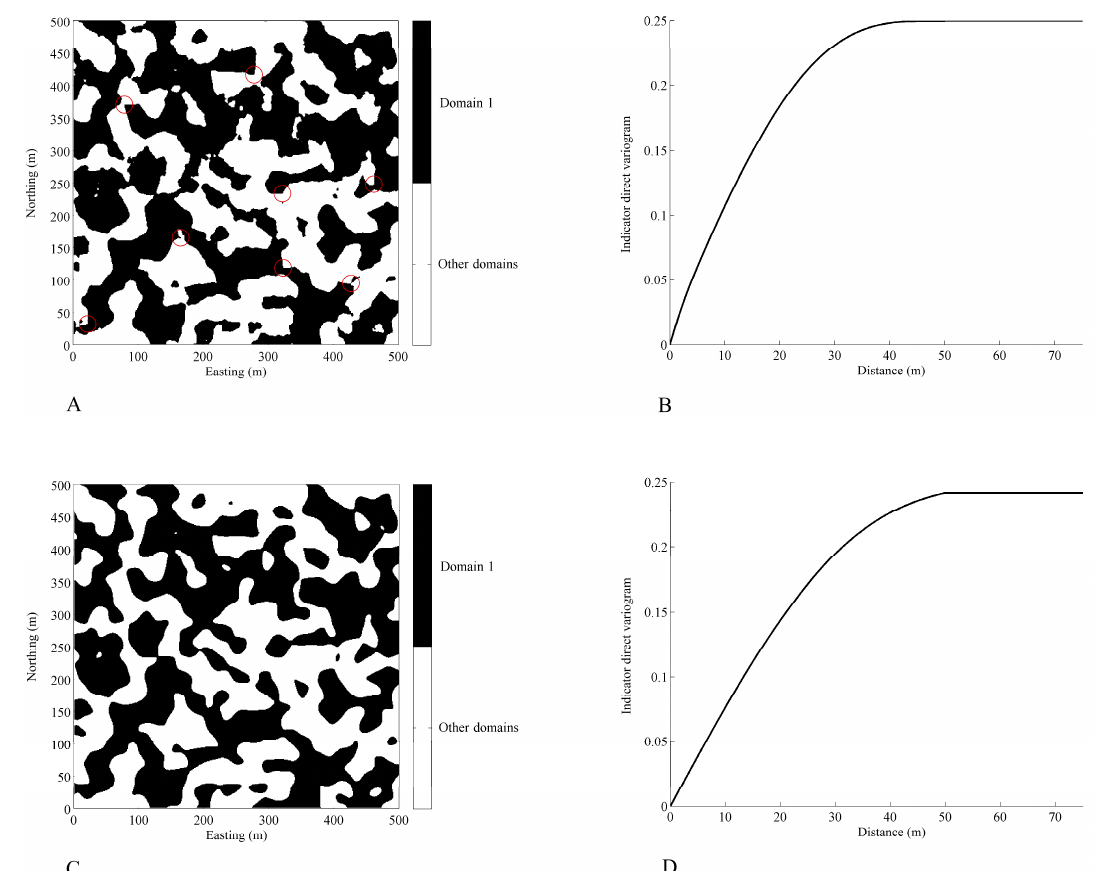
Figure 2. Plan views of geological domains ( A , C ) and indicator variograms of domain D 1 ( B , D ). The smoothness of the domain boundary is reflected in the second-order derivative of the indicator direct variogram at the origin: domain boundary with vertices highlighted in red ( A ) associated with a strictly concave variogram near the origin ( B ); smooth domain boundary ( C ) associated with a straight variogram near the origin ( D ).